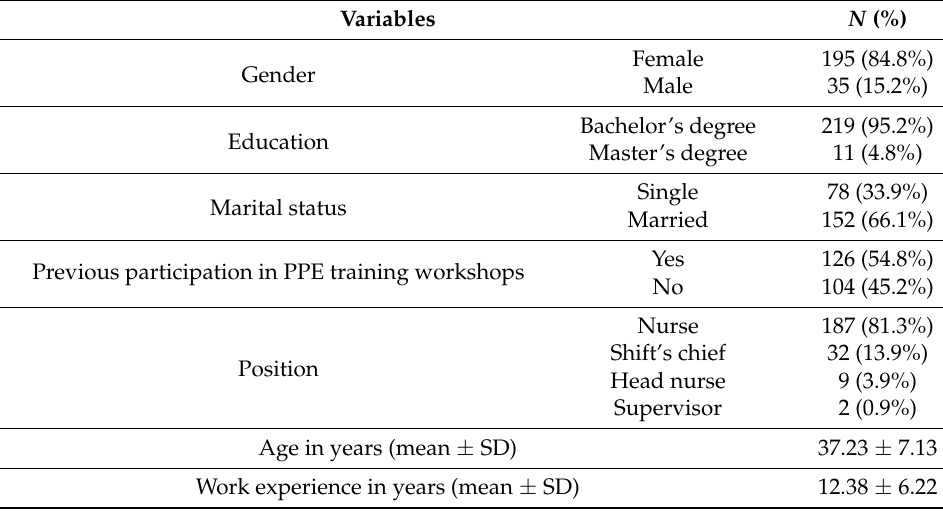
Table 1. Demographic characteristics of study participants.